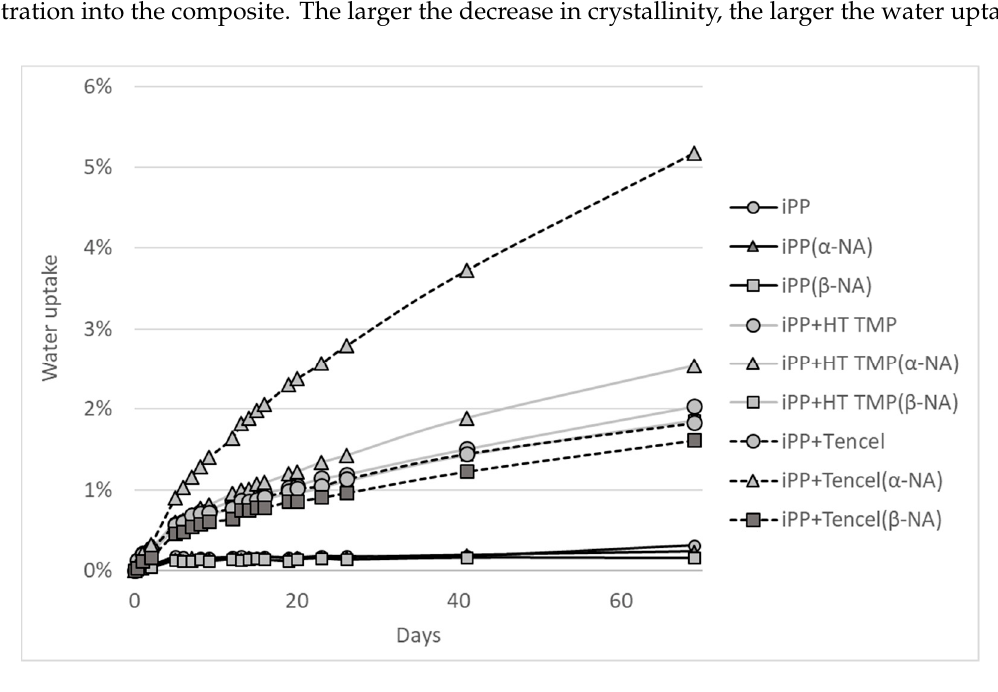
Figure 6. Water uptake of the various iPP composites. Table 2. Percentage of water uptake of iPP composites after 70 days (n = 3, different letters indicate significant difference at α = 0.05).